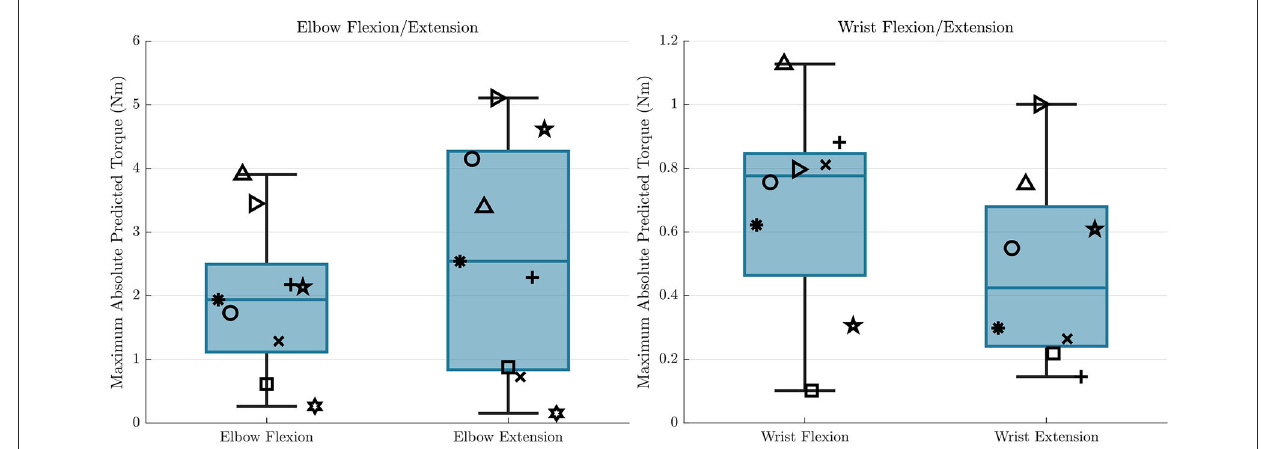
FIGURE10 The maximum absolute values of the GPR predictions throughout the workspace for all participants are shown for each electrode, and for each DOF. This represents how different participants are able to achieve different levels of torque from FES when the participant is receiving maximum stimulation. The symbols here correspond to the same symbols from Figures 6,